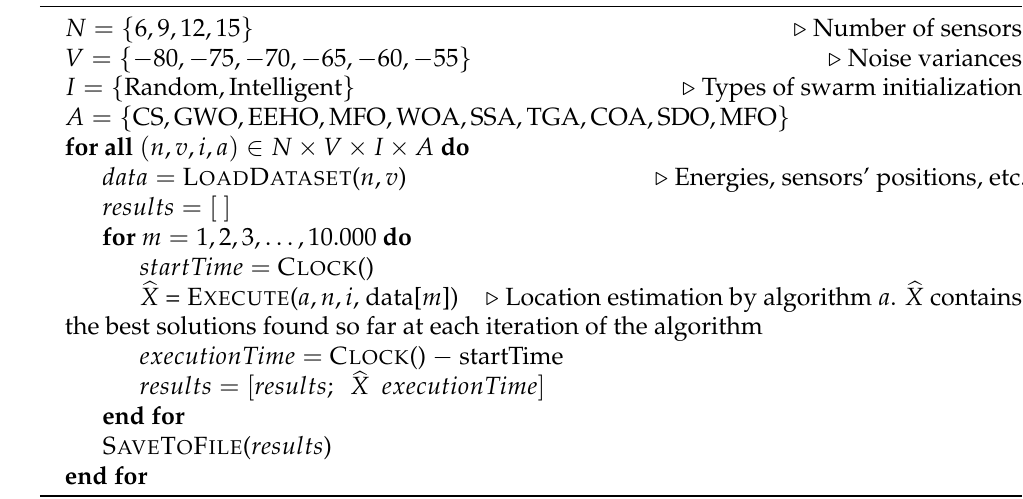
Algorithm 2 Testing procedure on the Raspberry